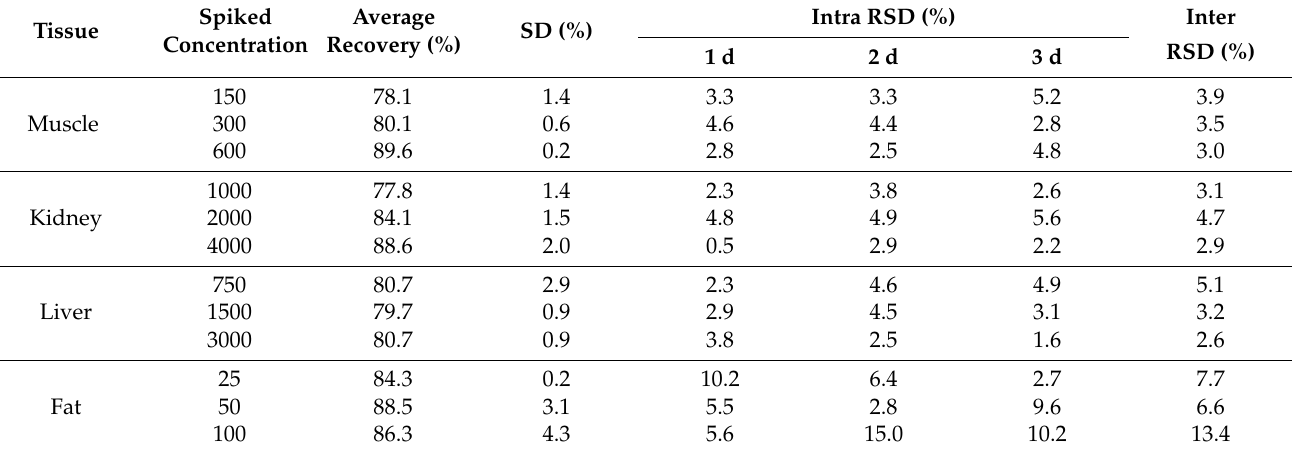
Table 5. The average recovery, intra RSD, and inter RSD of IMD in cattle tissues at 3 spiked concen- trations ( µ g/kg).